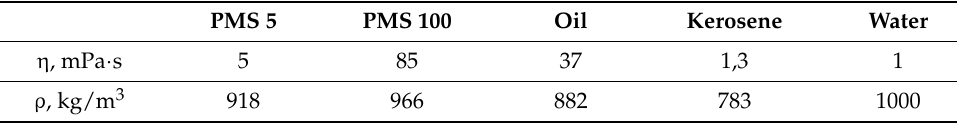
Table 2. Physical parameters of non-magnetic fluids.